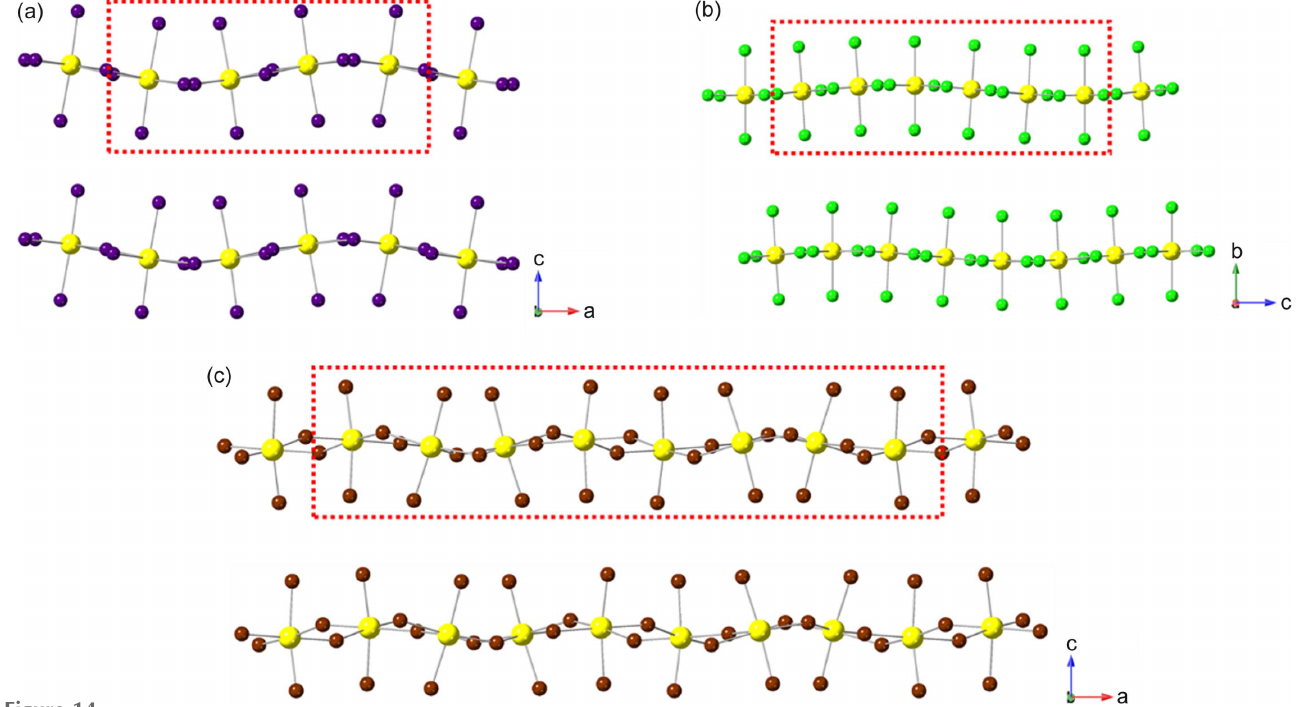
Figure 14 Ball and stick representations of ( a ) [C 5 H 16 N 2 ]PbI 4 (995699), ( b ) [C 2 H 4 N 3 ] 2 PbCl 4 ([TzH] 2 PbCl 4 ) and ( c ) [C 9 H 14 N] 2 PbBr 4 1995236). These compositions feature doubled, tripled and quadrupled ‘sinusoidal rippling’, respectively. This is highlighted by the dashed red box in